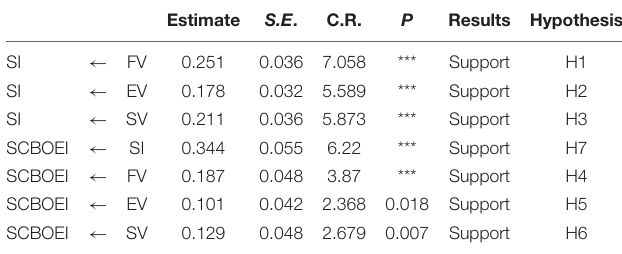
TABLE 8 | Path coefficient estimate of the final model. Estimate S.E .